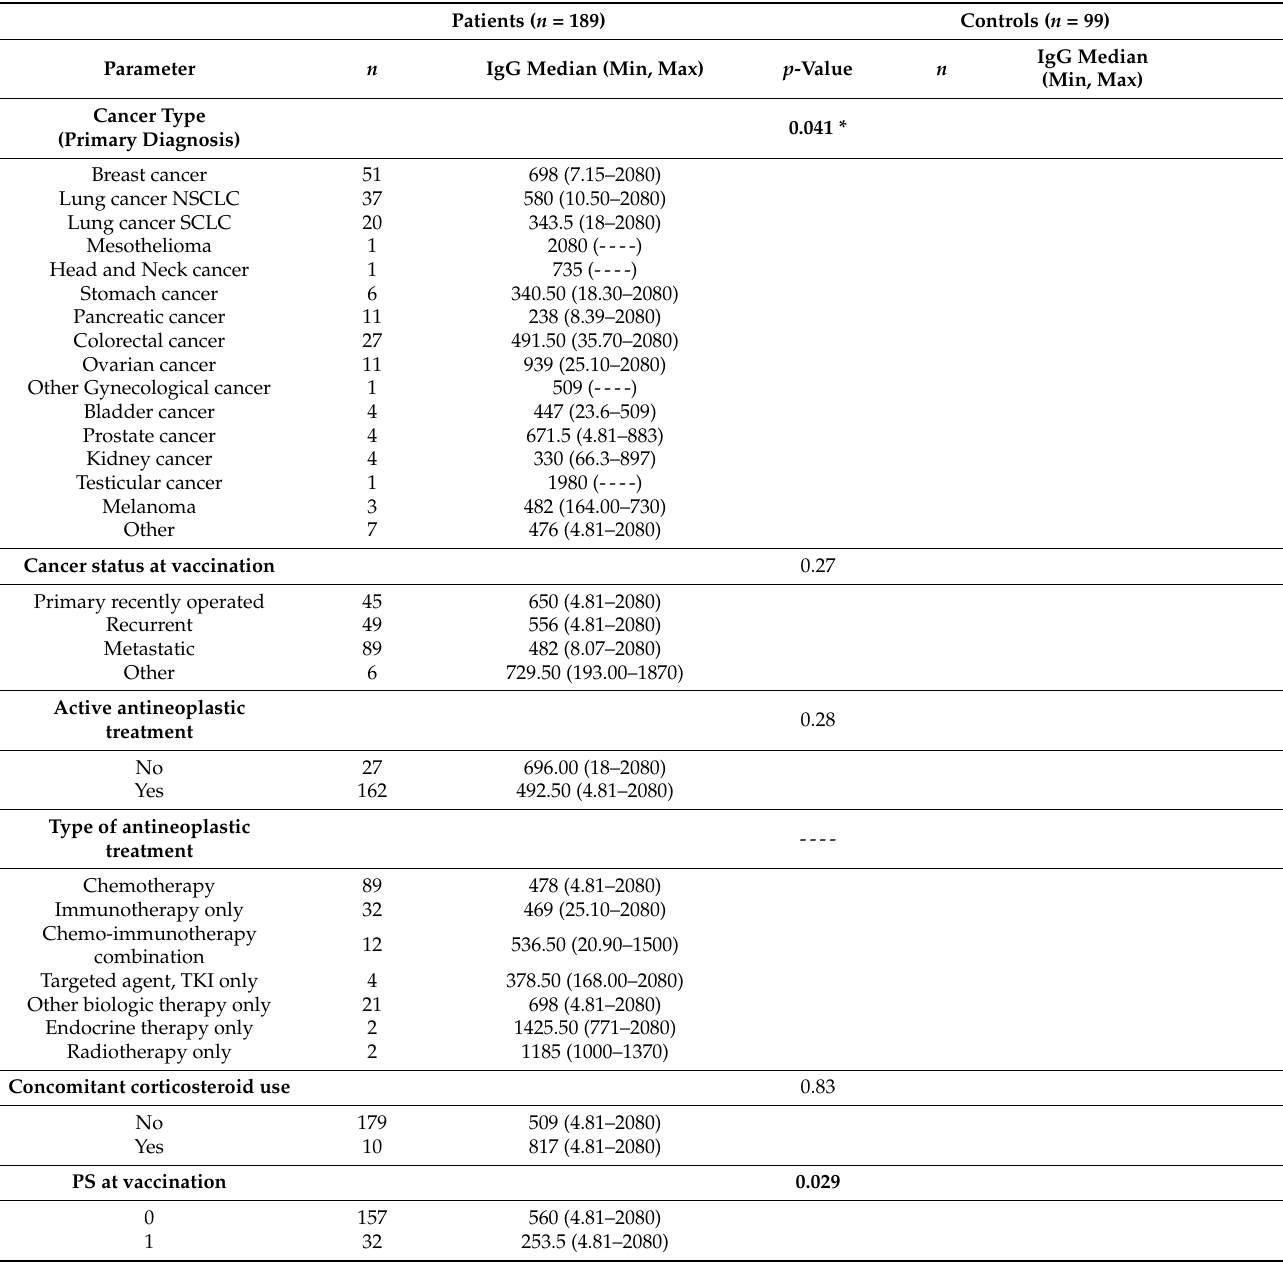
Table 2. Association of antibody titers with baseline characteristics in patients and